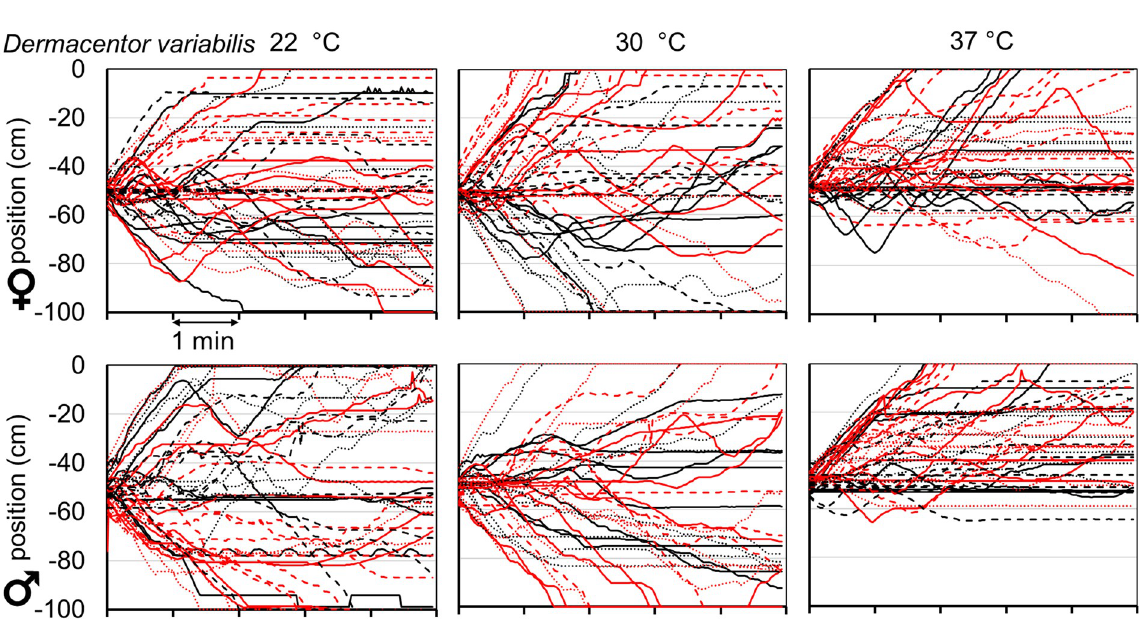
Fig 3. Tracks of individual Dermacentor variabilis ticks in thermotaxis trials. Longitudinal position vs. time as in Fig 2, but for D . variabilis ticks.